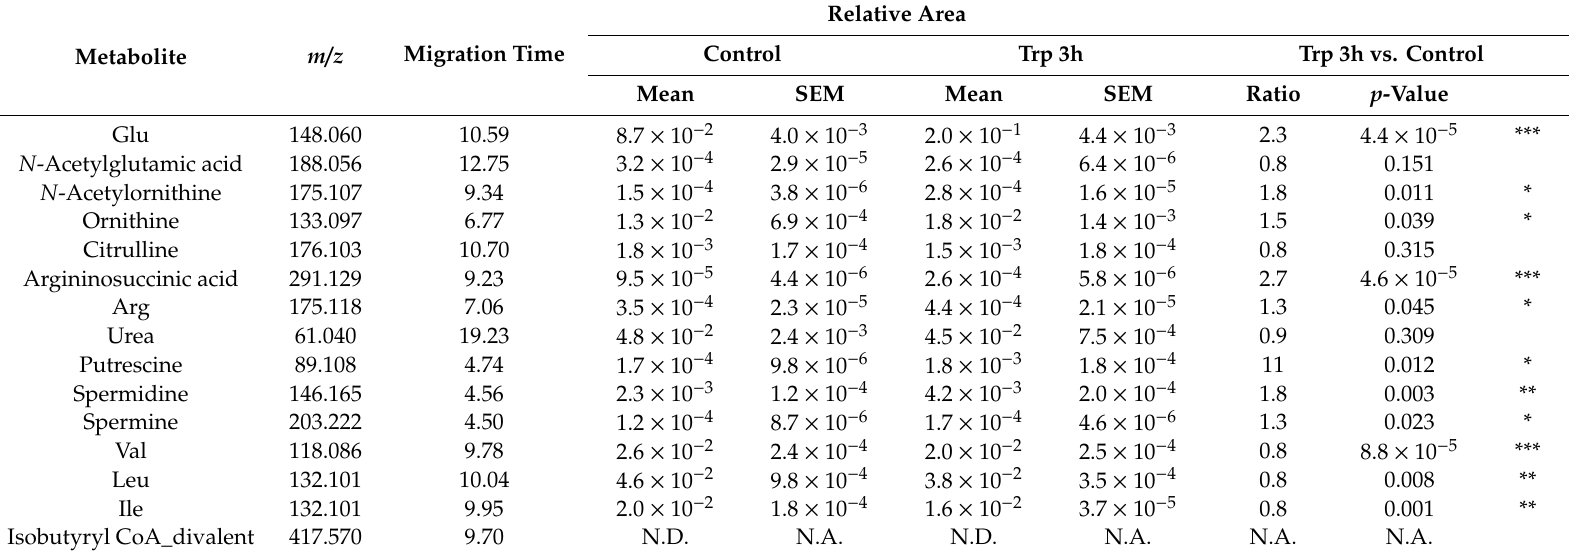
Table 2. Changes in the hepatic levels of polyamines, related amino acids, and BCAAs at 3 h after Trp administration.